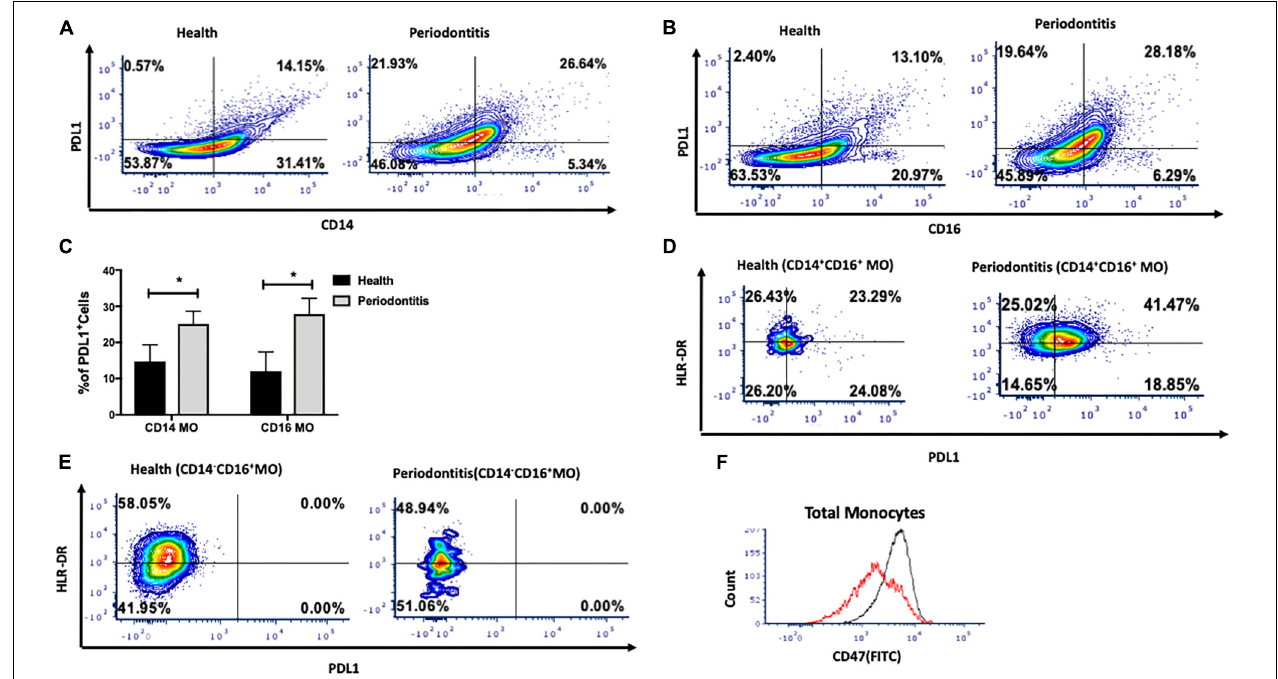
FIGURE 2 | Single cell suspensions from matched periodontitis-affected and healthy gingival tissues were prepared and stained for UV Zombie, CD45, Lin, HLA-DR, CD16, CD14, and PDL1. (A–C) : Representative counter plots of CD14 + PDL1 + and CD16 + PDL1 + cells. Frequency of both cell types was higher in periodontitis-affected tissue compared to matched controls ( n = 14; p < 0.05). (D,E) : Representative counter plots of intermediate and non-classical monocytes based on HLA-DR and PDL1 expression. HLA-DR + PDL1 + population was only detectable in intermediate and not in non-classical monocytes. (F) Flow cytometry histogram of FITC-labeled CD47 expression in monocytes in periodontitis-affected tissue (black line) compared to healthy tissue (red line). The histogram was normalized to the number of events and depicts increase in CD47 in periodontitis-affected sites. Data presented as mean ± SEM and p less than 0.05 was defined as significant (the symbol “*” indicates p <